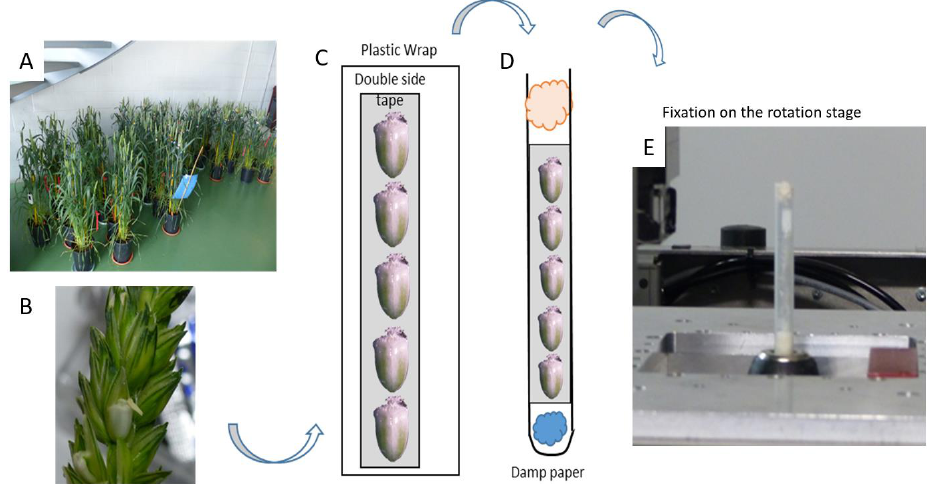
Figure 1. Grain sampling and preparation for acquisition. ( A ) Wheat plants. ( B ) A wheat grain within a spikelet. ( C ) Fixation of the grains using adhesive and plastic wrap. ( D ) Insertion into the tube. ( E ) Installation on the rotation stage in front of the X-ray beam.